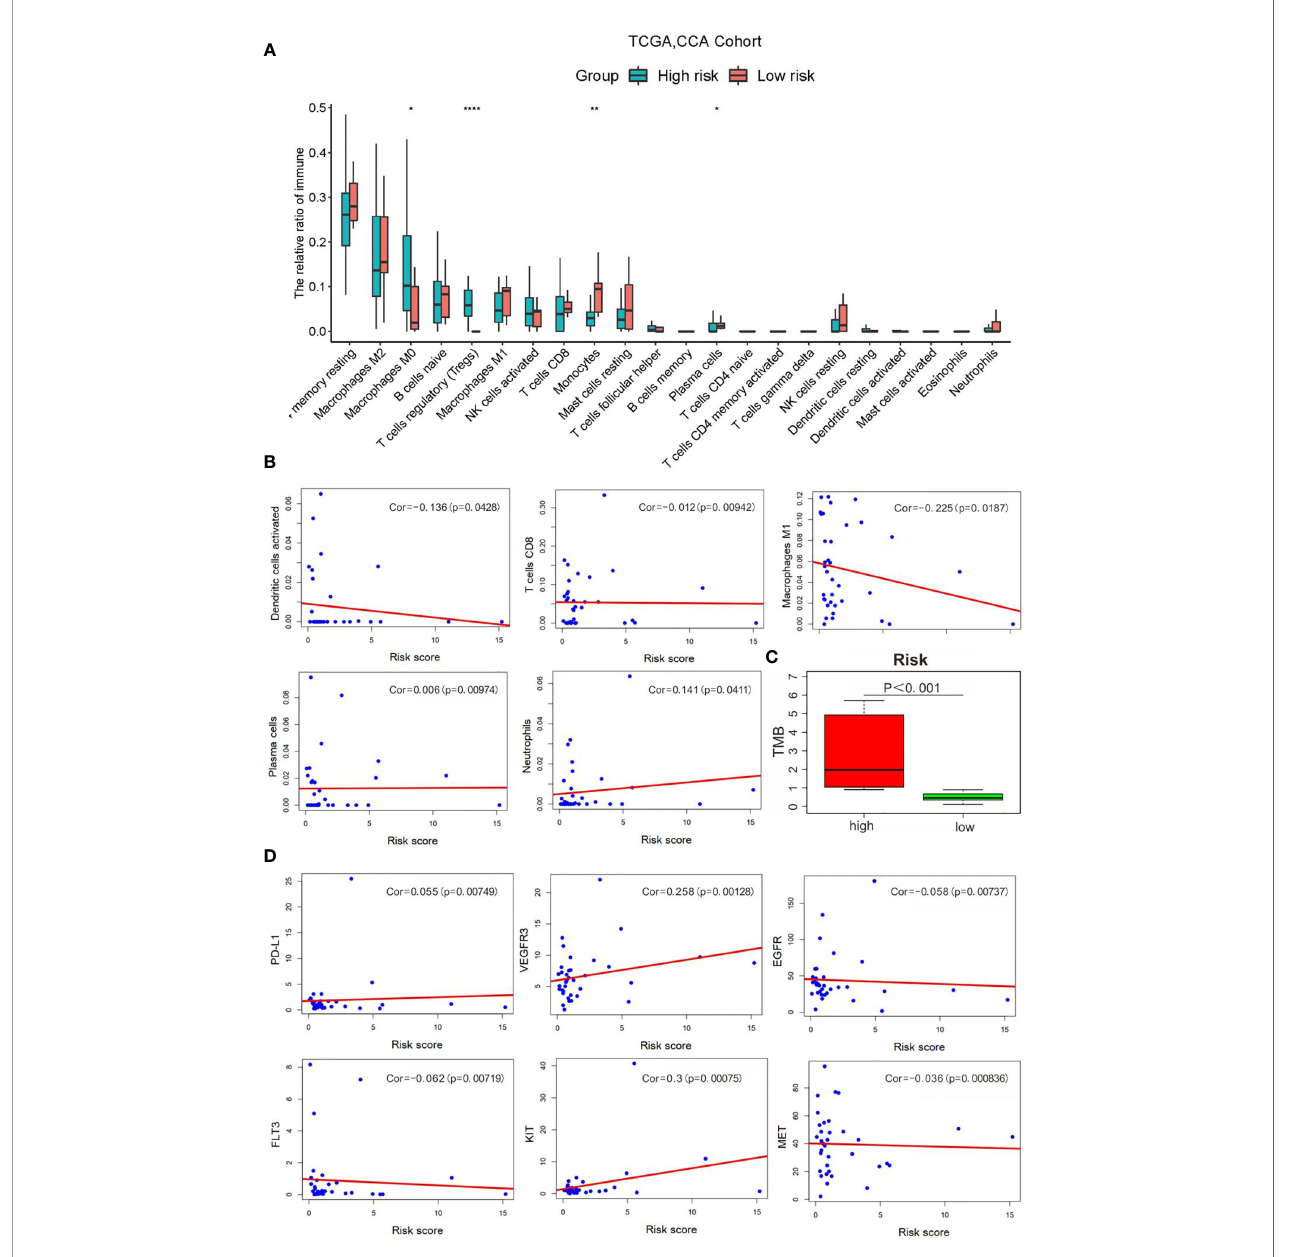
FIGURE 9 | Correlation analysis of risk scores with the clinical characteristics, immune cells and therapy targets. (A) Relative in fi ltration expression of 22 immune cells between different risk groups. (*P < 0.05, **P < 0.01, ****P < 0.0001); (B) Correlation of with immune cells; (C) TMB evaluation; (D) Correlation with therapy